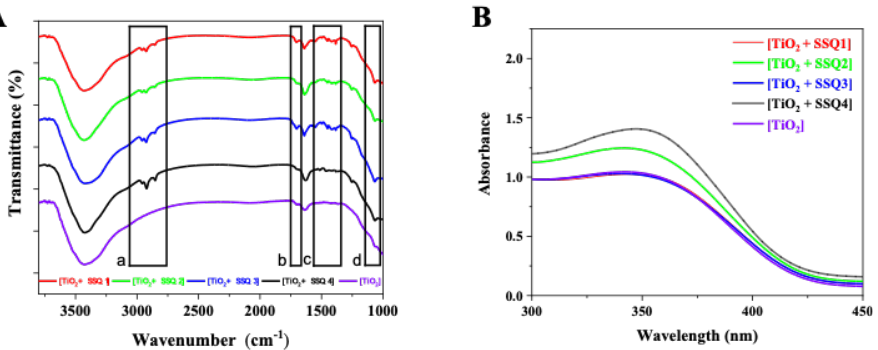
Figure 6. FT-IR ( A ) and UV-Vis ( B ) spectra of modified titanium dioxide. In Figure 6B, the UV-Vis spectra of nonmodified and modified titanium dioxide is presented. All materials absorb light at a wavelength below 400 nm. Similar spectra of pure TiO 2 were recorded by Zhao et al. [31]. The results proved that all new materials exhibit strong absorption in the ultraviolet region. The modification of titanium dioxide did not shift the absorption maximum to higher wavelengths. The influence of modifying titanium dioxide with spherosilicates on particle size dis- tribution was also tested. A monomodal particle size distribution between 0.04 and 1.00 µm for titanium dioxide was observed (Figure 7). These results are in accordance with data recorded by Song et al. [32]. For all modified materials a monomodal particle size, distribution was also detected, and no significant changes compared to pure titanium di- oxide were observed.